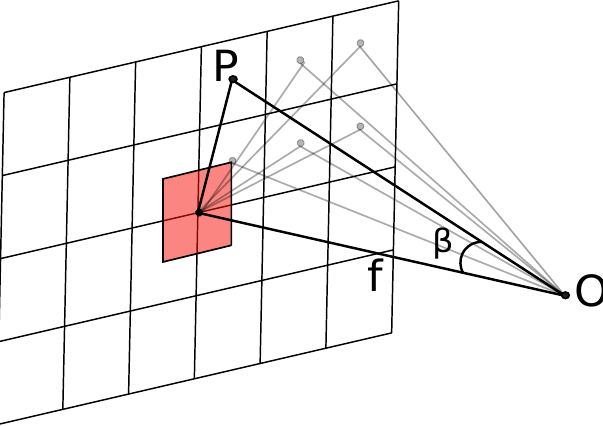
Figure 6. IR sensor power reaching single-pixel. Figure 6 illustrates how the power reaches a specific pixel, where point O is the exit 187 pupil’s centre of the lens. The small horizontal squares represent the pixels of the sensor. 188 The red square represents the single-pixel area at the centre of the sensor. The distance 189 l between point O and the centre of the sensor is also the focal length. Further, we can 190 compute the distances between the point O and every pixel centre, e.g. point P . The angle 191 β is formed by the pixel, point O and sensor’s centre. In our model we assume that IR power incident on any pixel-sensitive surface is 193 reduced by cos 4 β factor in comparison with the IR power incident on the red square area 194